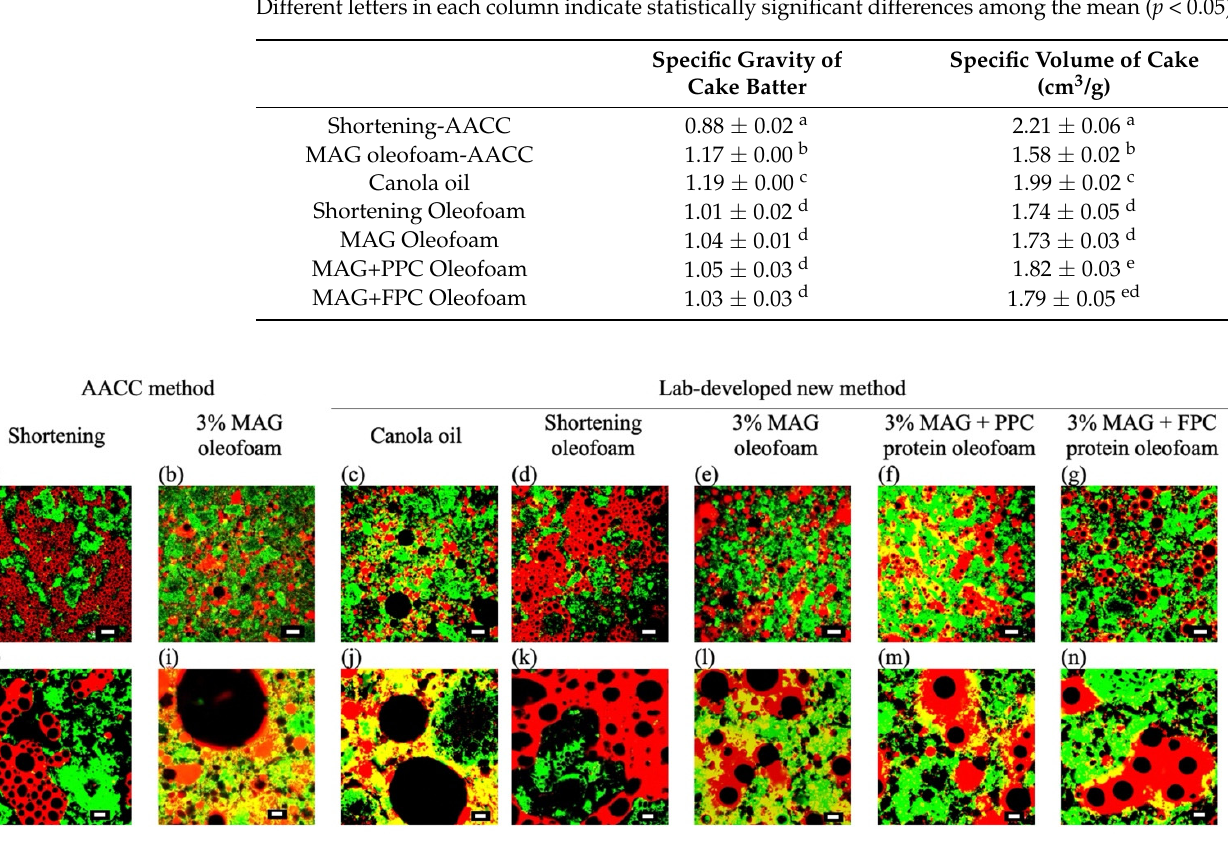
Figure 4. The confocal microscopic images of cake batters prepared using various fats using either AACC or lab-developed method. AACC method: Shortening ( a , h ), MAG oleofoam ( b , i ). Lab-developed method: canola oil ( c , j ), shortening oleofoam ( d , k ), 3%MAG oleofoam ( e , l ), 3% MAG with PPC protein foam-templated oleofoam ( f , m ), and 3%MAG with FPC protein foam-templated oleofoam ( g , n ). Images were taken using 10X (top row, a – g , scale bar 100 µm) and 40X (bottom row, h – n , scale bar 20 µm) objective lens. The oil phase in the cake batters was stained using Nile red (red color), and the protein was stained with fast green (green color). The dark phase indicates starch and water, and the dark bubbles indicate air bubbles. MAG, monoacylglycerols; PPC, pea protein concentrate-stabilized foam; FPC, faba bean protein concentrate-stabilized foam.